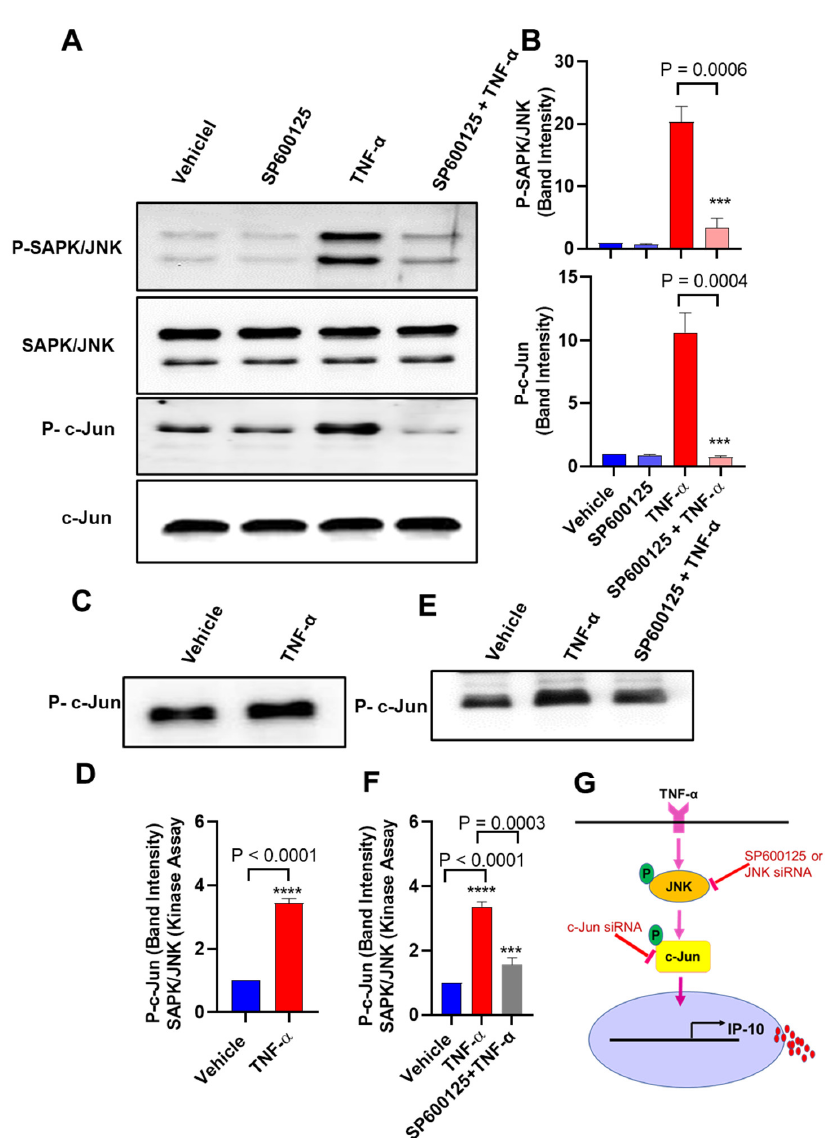
significant decrease in the TNF- α -induced JNK and c-Jun phosphorylation (Figure 5A,B). We further examined the effect of TNF- α stimulation on the kinase activity of JNK. To this end, lysates of MCF-7 cells were incubated overnight with 20 µ L of c-Jun fusion protein beads, and then a kinase assay was performed. Results show that the kinase activity of JNK in TNF- α -stimulated MCF-7 lysates was significantly upregulated compared to that in control lysates (Figure 5C,D), while the pre-incubation with SP600125 inhibitor significantly suppressed TNF- α -induced JNK kinase activity (Figure 5E,F).